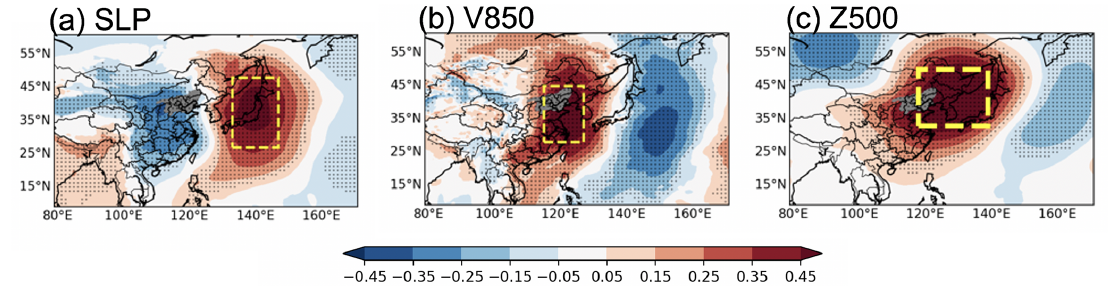
Figure 5. Correlation coefficients of daily PM 2 . 5 concentrations in BTH with (a) SLP, (b) V850 and (c) Z500 during DJF 2013–2017 (dotted regions indicate significant correlations at the 95% level from the two-tailed Student’s t test). Grey shading represents the BTH region. The broad region presenting the highest correlation with BTH is marked by a yellow rectangle in each panel. The region used for the definition of a circulation-based index (Eq. 3) is marked by a thick yellow rectangle in (c)